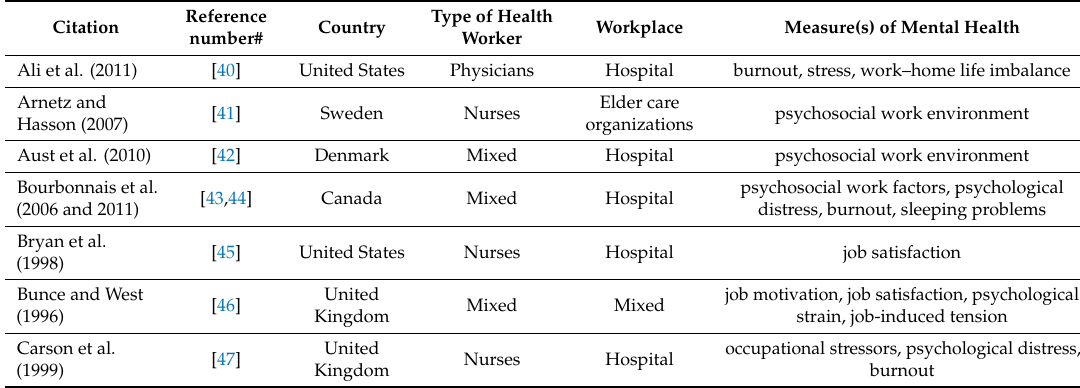
Table 2. Summary of